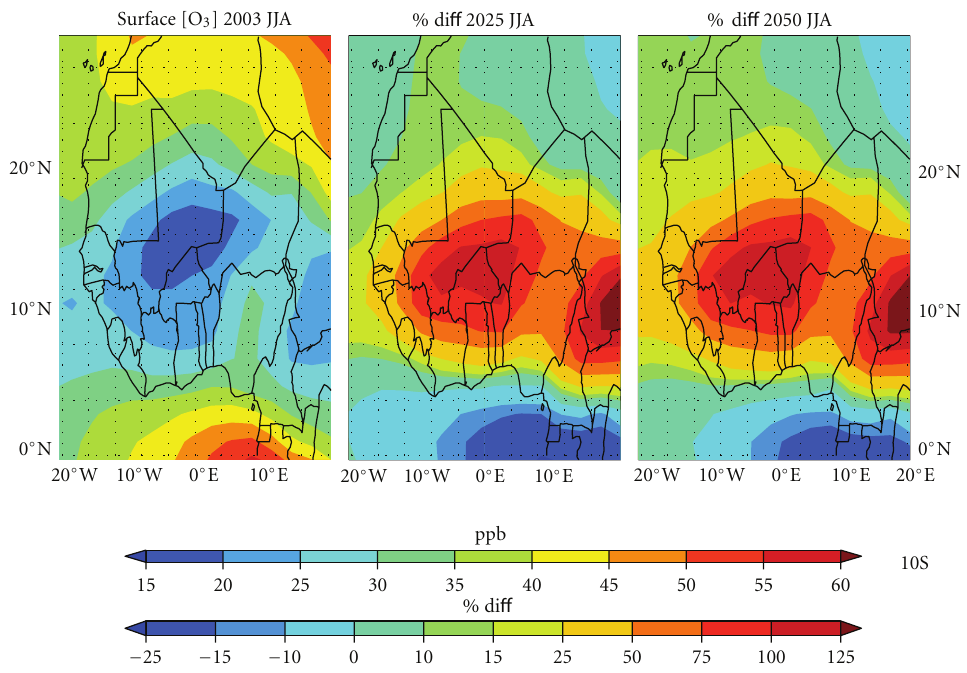
Figure 4: Seasonal mean of tropospheric O 3 in the lowest km of the atmosphere for JJA during 2003 over West Africa. Percentage di ff erences are shown when compared against the A1B 2025 (middle) and A1B 2050 (right)